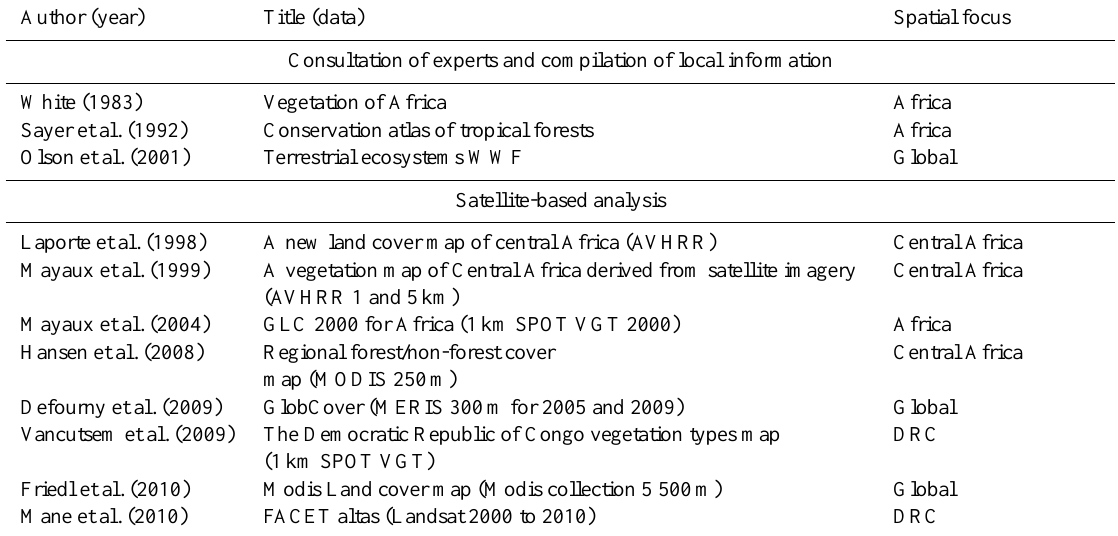
Table 1. Land cover maps with a specific focus on Africa and recent global land cover maps Author